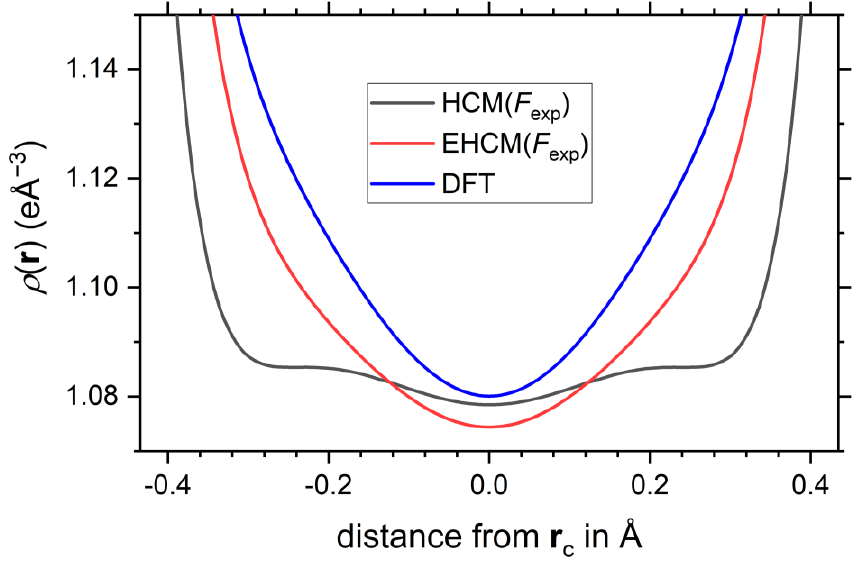
Figure 7. 1D-profile of the electron density along the exo -B p -B p bond.